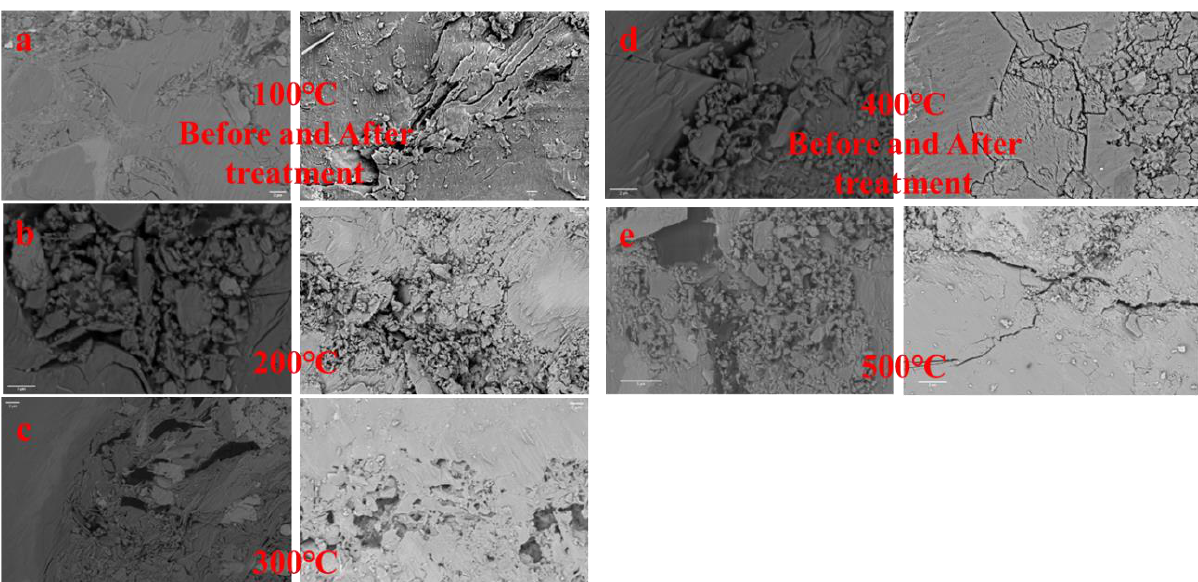
Figure 1. Shale surface structure before and after the Sc-CO 2 reaction. ( a ) SEM images before and after the Sc-CO 2 reaction of 100 ◦ C. ( b ) SEM images before and after the Sc-CO 2 reaction of 200 ◦ C. ( c ) SEM images before and after the Sc-CO 2 reaction of 300 ◦ C. ( d ) SEM images before and after the Sc-CO 2 reaction of 400 ◦ C. ( e ) SEM images before and after the Sc-CO 2 reaction of 500 ◦ C.